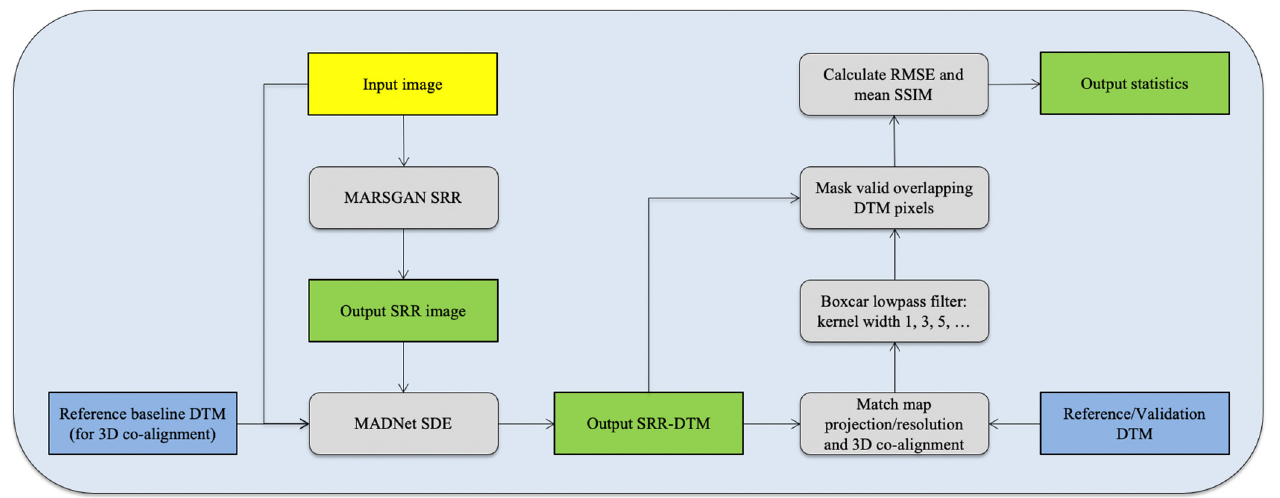
Figure 4. Flow diagram of the processing and evaluation methods.